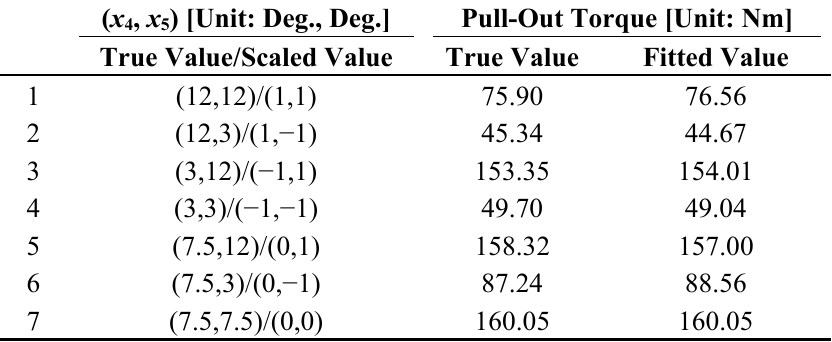
Table 4. Experiment results using CCD for optimizing stator